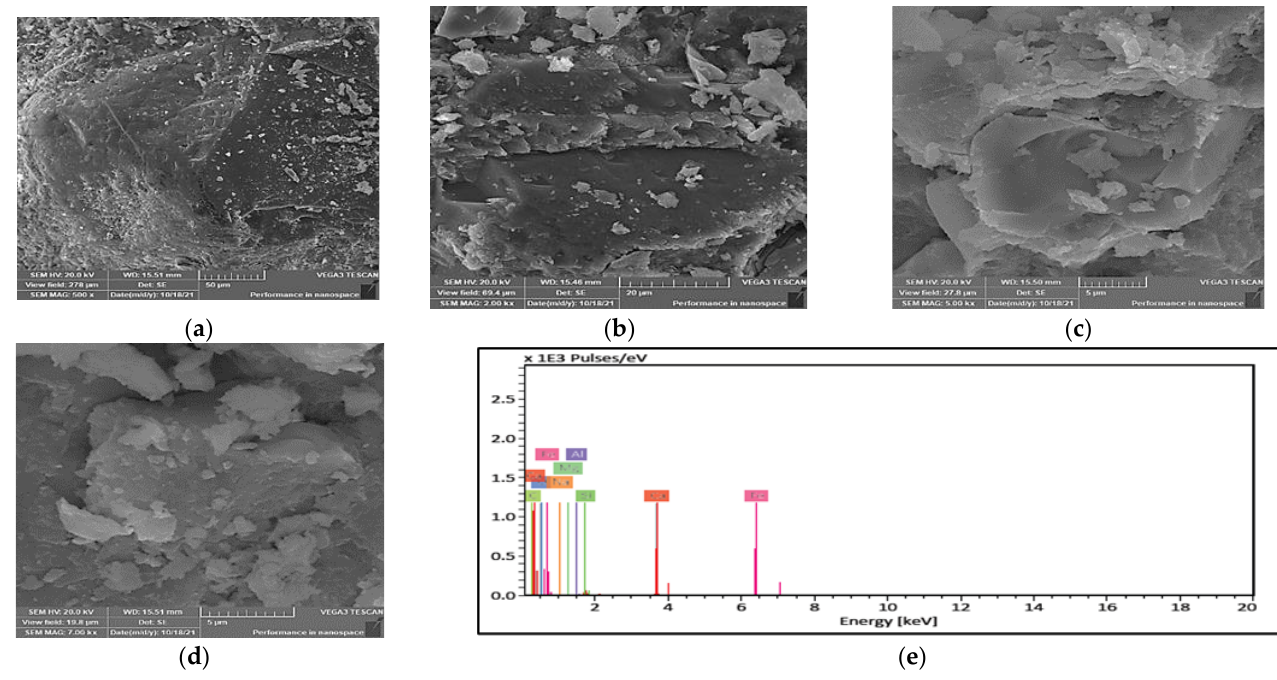
Figure 12. SEM with various magnification factors ( a – d ); ( e ) EDX for the control mix at 22 ◦ C curing